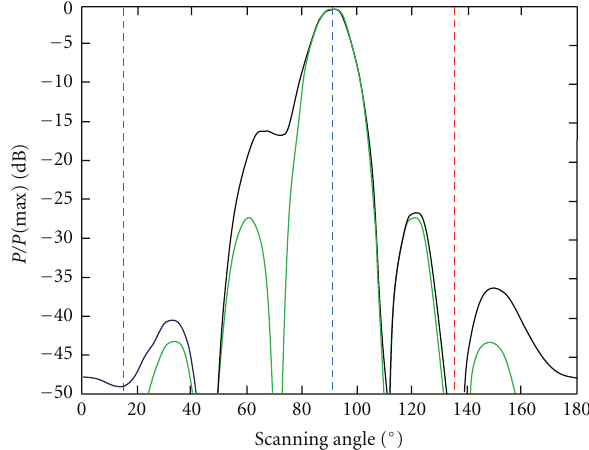
Figure 19: An ANN beam pattern pointed towards the signal with the right angle.